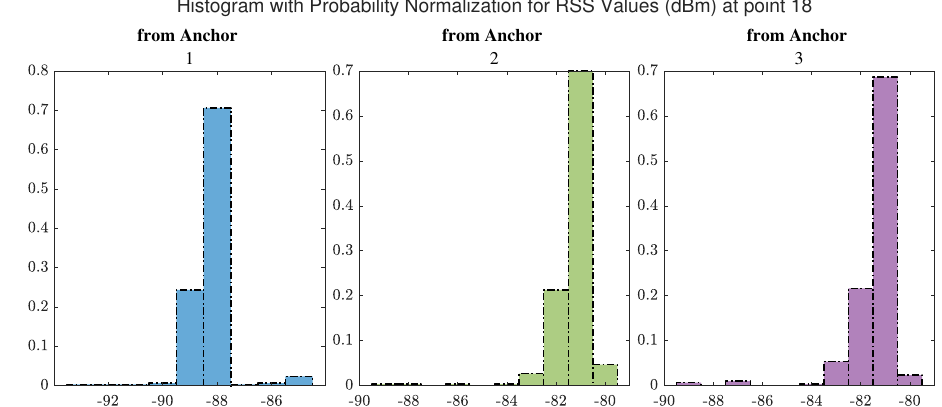
Figure 17. Distribution of RSS values received from UWB anchors at point